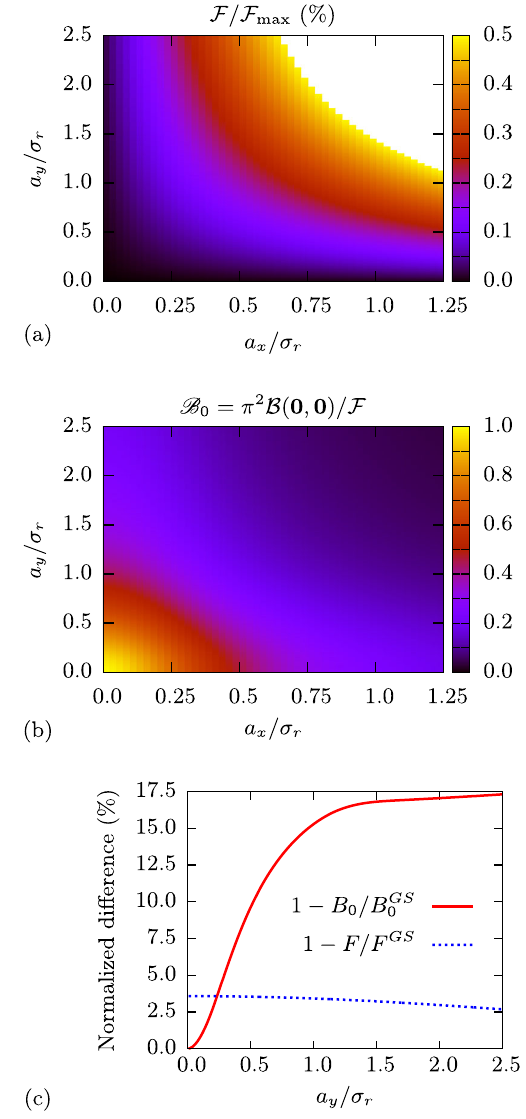
FIG. 6. Effect of a square slit of size a × a in the transverse x y plane on undulator radiation. The aperture is located downstream at z ¼ 8 L , and the undulator field is produced by a beam whose u parameters are given in Table I. (a) plots how the flux decreases with slit size, while (b) gives the coherent fraction ℬ 0 . To achieve a highly coherent beam with ℬ 0 > 0 . 5 requires a very small ˆ ε ∼ 10 − 3 of the flux F . slit that sacrifices all but ∼ 1 = ð ˆ ε x y Þ Panel (c) compares the result here that decomposes the field using the more accurate (42) with the Gaussian-Schell model of the previous section. We see that the Gaussian-Schell model overestimates the flux and source strength, but that the agreement is reasonably good for the very small apertures required to produce highly coherent x